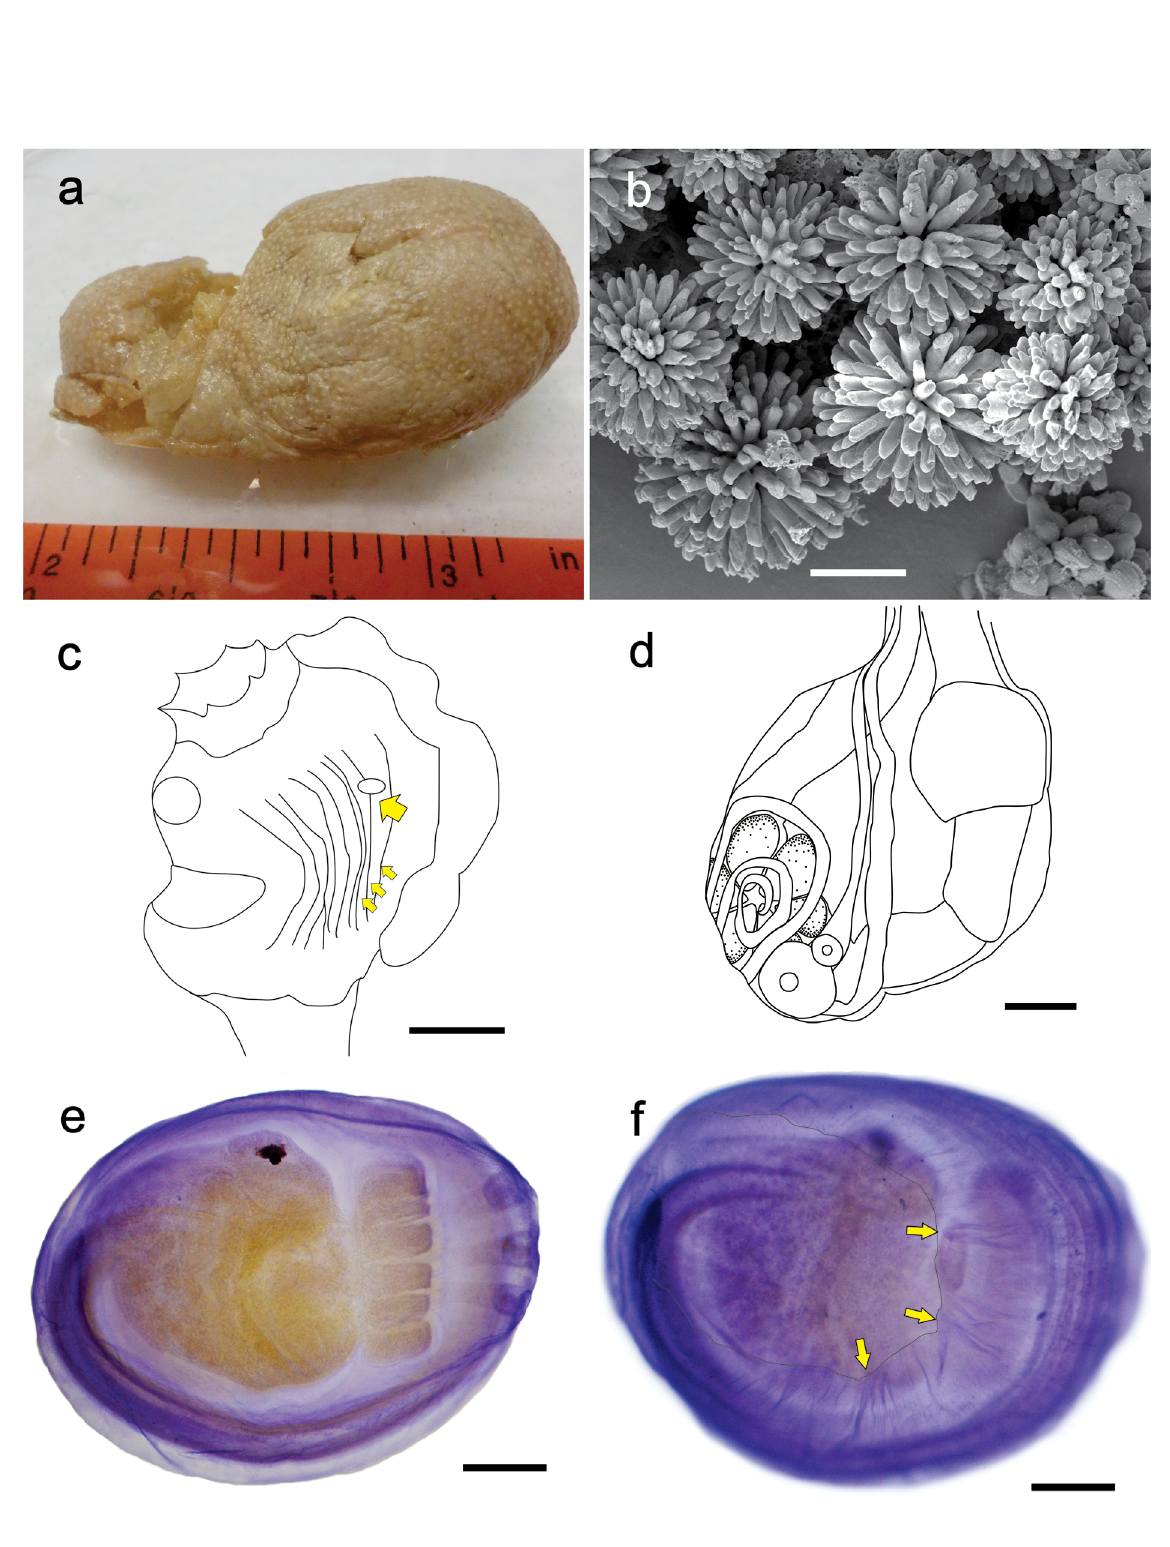
Fig. 7. Polysyncraton globosum Oliveira & Rocha sp. nov., Australia (NHM 1866.3.21.21). a . Preserved colony. b . Spicules. c . Thorax (big arrow indicates the lateral thoracic organ and small arrows the muscle fibers present on each side of the thorax). d . Abdomen. e–f . Larva stained with hemalum (the arrows in f indicate the membrane of the tail). Scale bars: b = 10 µm; c–d = 0.1 mm; e–f =